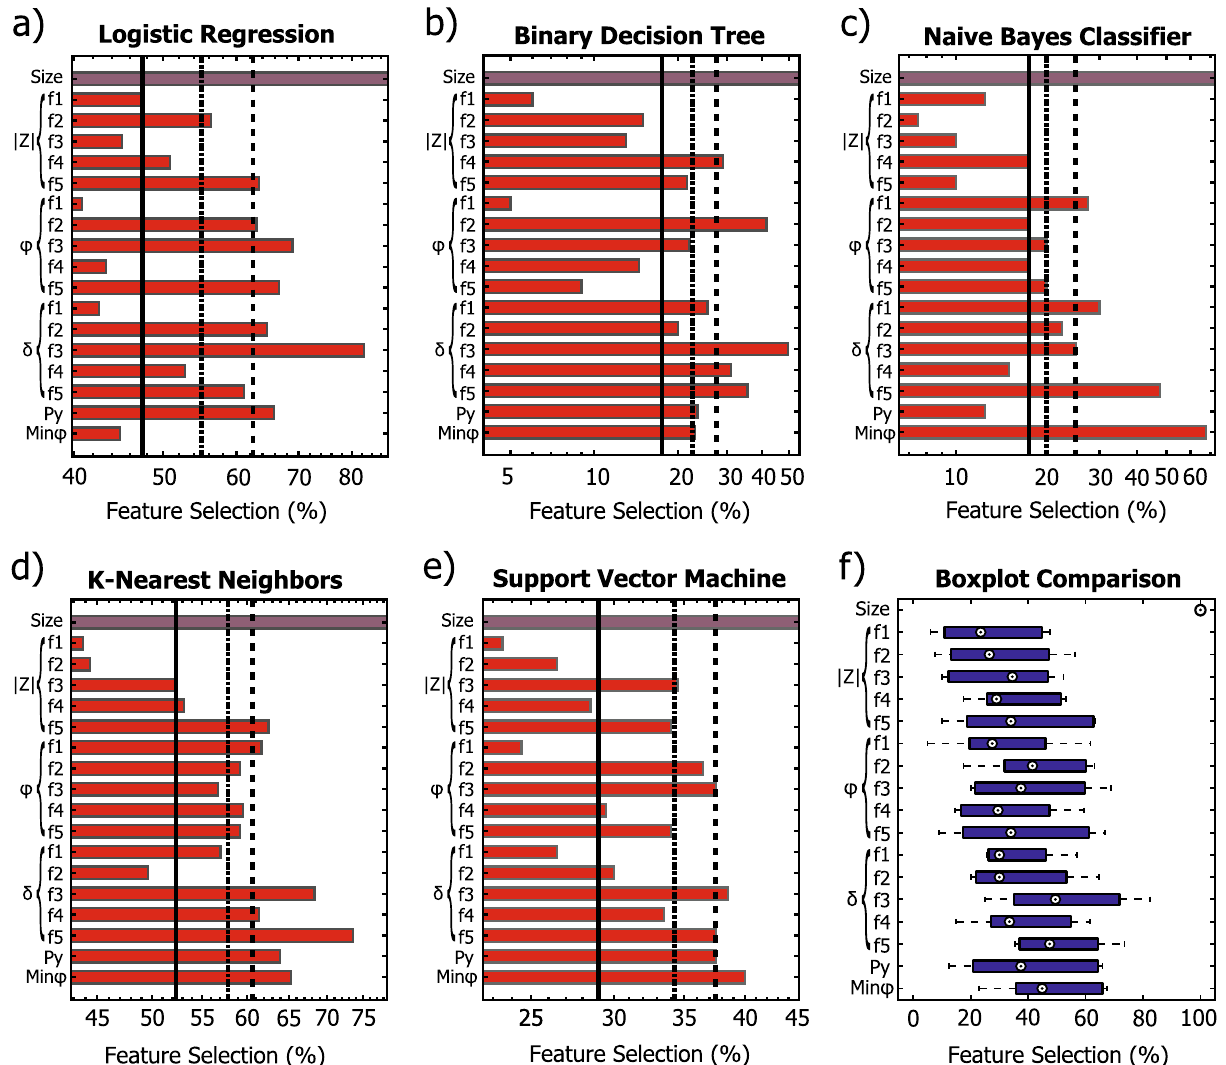
Figure 6. Sequential feature selection of the starting 18 parameters, together with the 3 selected numerosity thresholds (low solid line, medium dash dotted line, high dashed line) for each model ( a – e ). Boxplot comparison ( f , blue filled square) of the feature selection among the models. As decided form previous considerations, the fruit size feature (violet filled square) is always selected, the 17 other features (ref filled sqaure) are subject of the feature